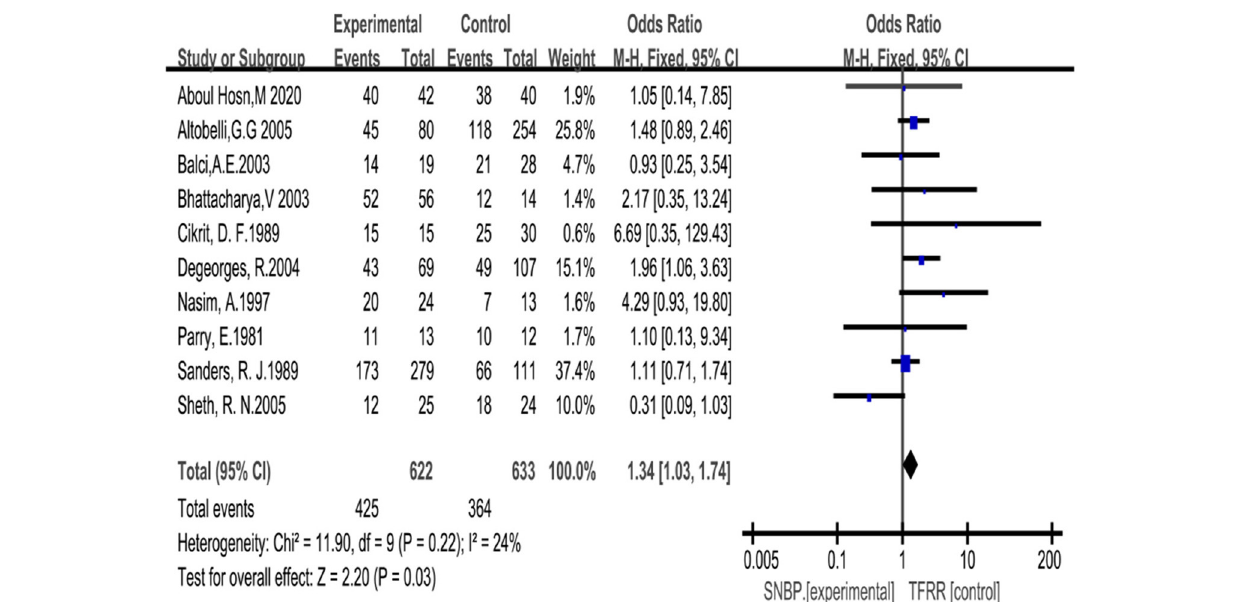
Frontiers in Neurology |